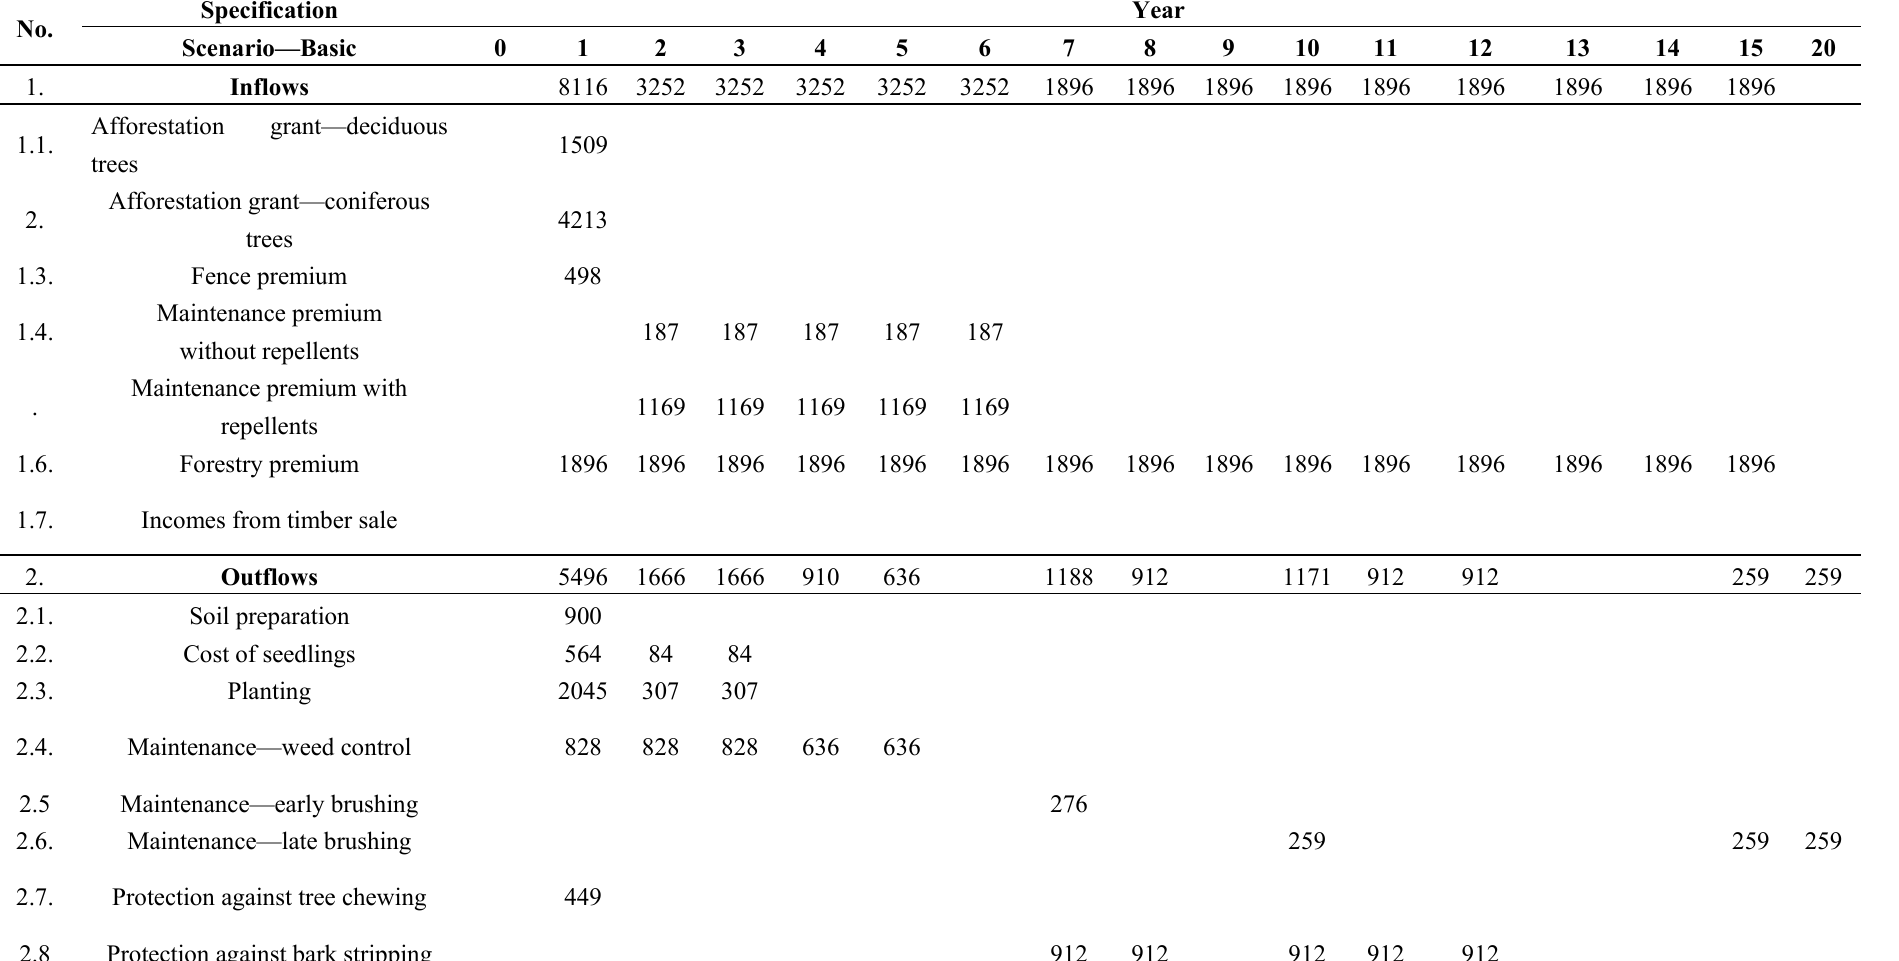
Table 2. Inflows and outflows associated with afforestation according to the three scenarios (Basic, Optimistic and Pessimistic), in EUR.